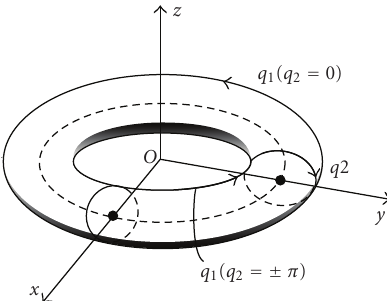
Figure 3: A two-dimensional torus is expressed by T 2 = S 1 × S 1